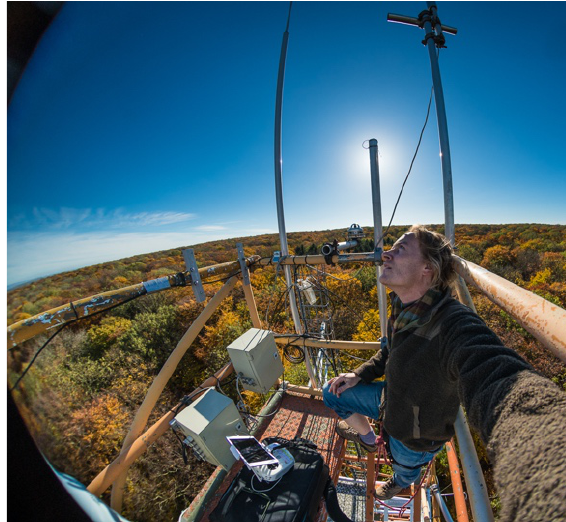
Figure 4: UAV start from the flux tower platform 40 m above ground level in the Hainich national park.